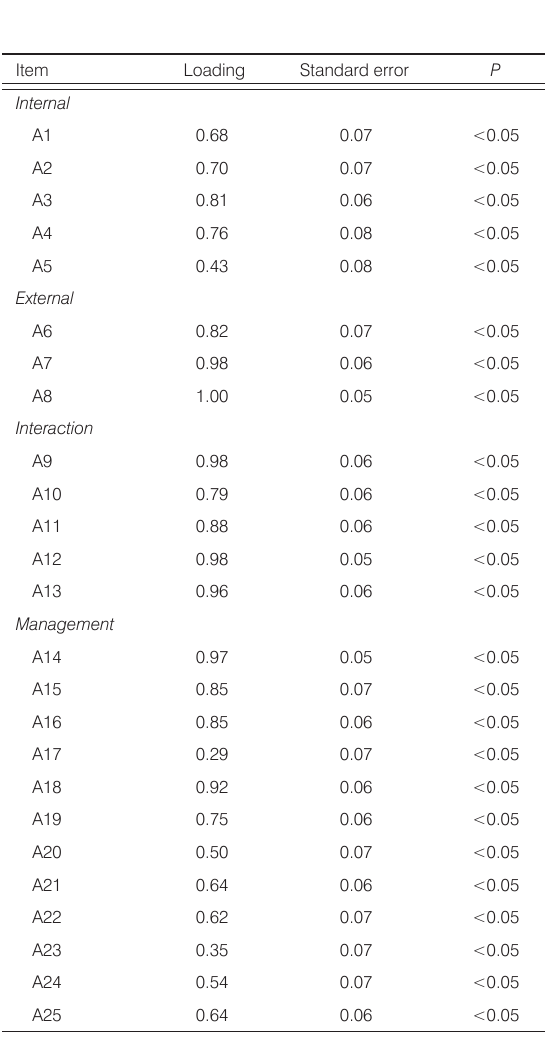
Table 3. Results of CFA of coefficient